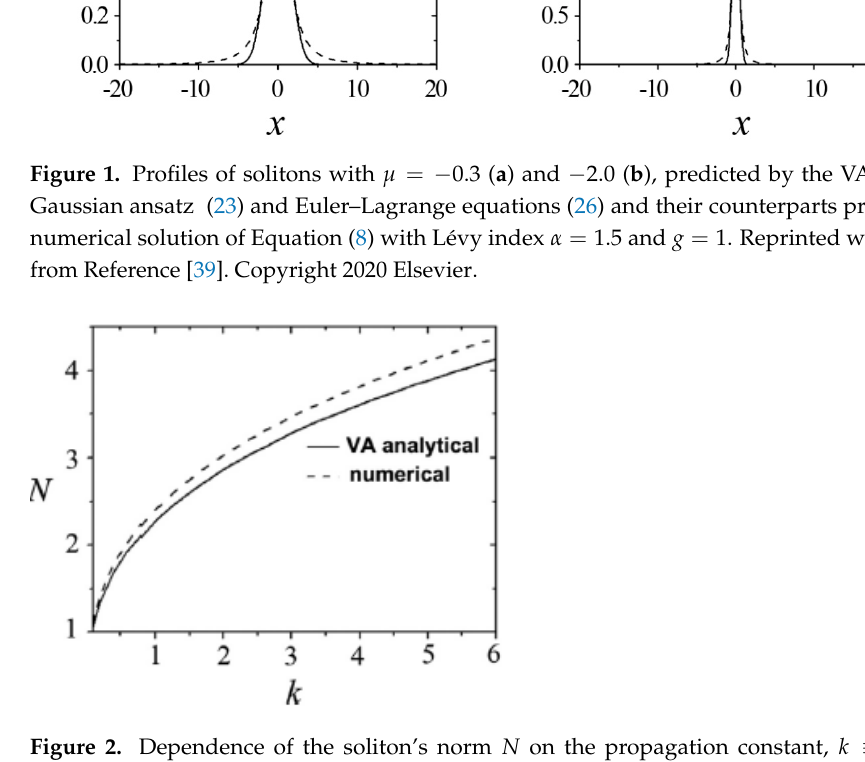
Figure 2. Dependence of the soliton’s norm N on the propagation constant, k ≡ − µ , for the Lévy index α = 1.5 and self-focusing coefficient g = 1, as predicted by the VA based on the Gaussian ansatz (23) and Euler–Lagrange Equations (26). The corresponding dependence obtained from the numerical solution of Equation (8) is included too. Reprinted with permission from Reference [39]. Copyright 2020